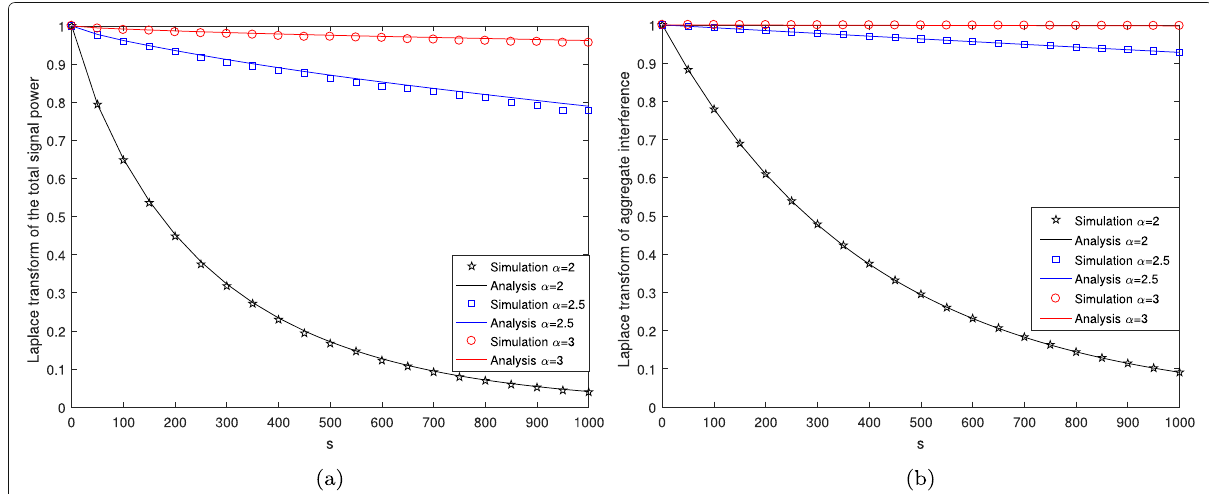
Fig. 4 The Laplace transform for PCP with different α . a The Laplace transform of the total signal power. b The Laplace transform of the aggregate interference